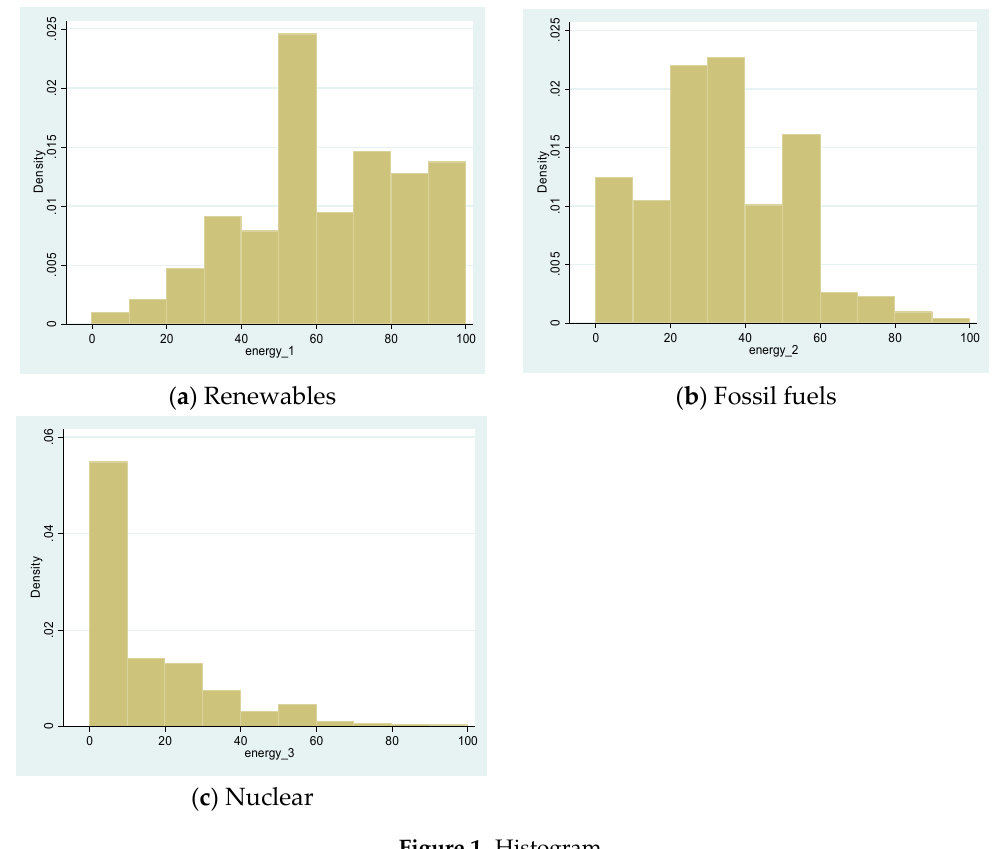
Figure 1. Histogram. Figure 1.